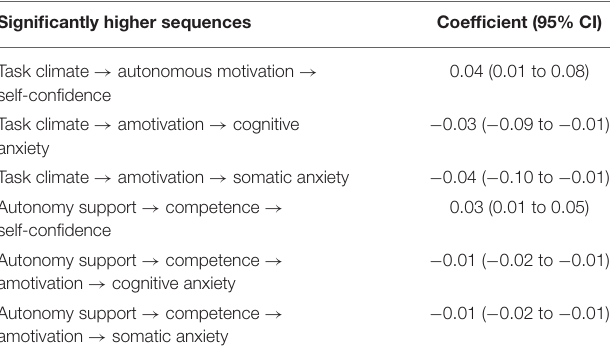
TABLE 3 | Superior combined indirect effects after contrast of mediators in the tested